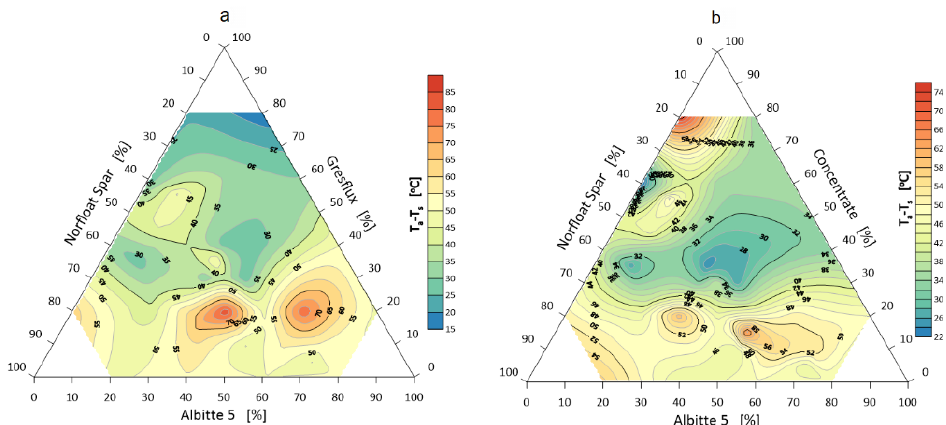
Figure 8. Sintering interval of the flux system Greflux–Albitte 5–Norfloat Spar ( a ), and Concentrate– Albitte 5–Norfloat Spar ( b ) .